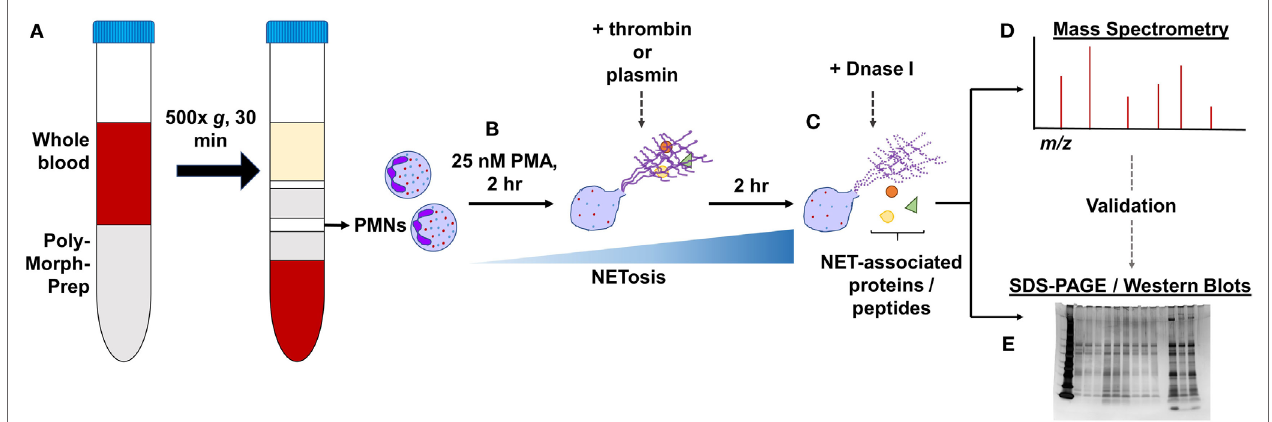
FigUre 1 | General experimental workflow. (a) Polymorphonucleated cells (PMNs) were isolated from three independent human whole blood samples by density centrifugation and (B) treated with 25 nM PMA for 2 h to induce neutrophil extracellular traps (NETs). PMNs were left untreated or supplemented with 1 µM thrombin or plasmin and incubated for another 2 h. (c) After gently washing the wells, they were further treated with 20 U/ml DNase I or with Rose Park Memorial Institute only for 1 h at 37°C to digest the DNA scaffold. The proteins extracted were then processed for (D) LC-MS/MS or (e) in some cases, subjected to validation by sodium dodecyl sulfate-polyacrylamide gel electrophoresis (SDS-PAGE)/western